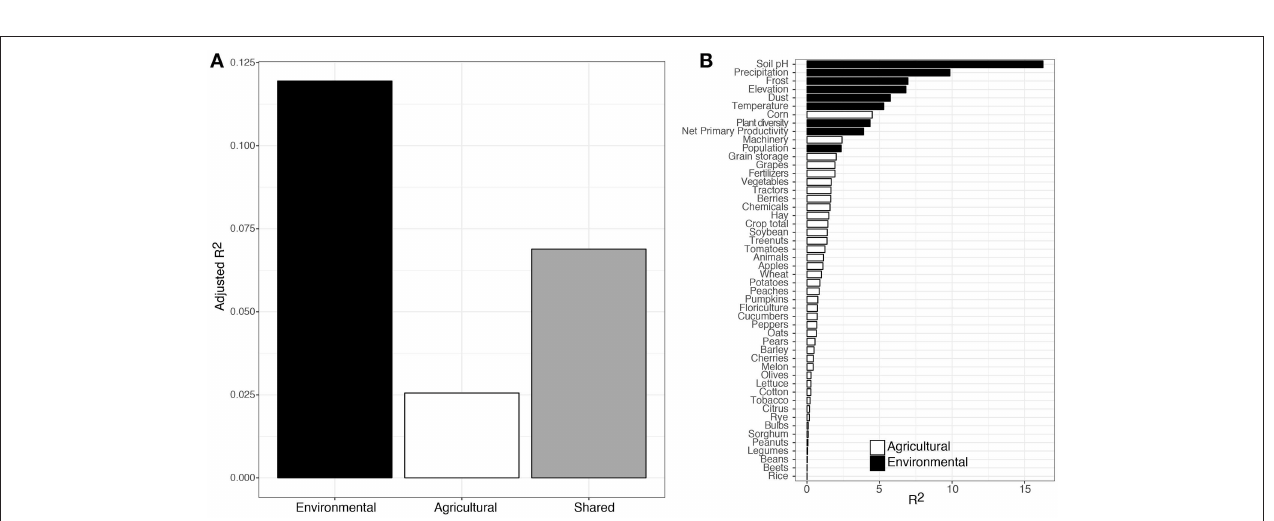
FIGURE 2 | Variance partitioning results showing the explanatory power of environmental (black) and agricultural (white) variables in relation to fungal plant pathogen community composition in dust samples (A) . Gradient forest analysis results showing the overall importance of individual variables on fungal plant pathogen community composition (B)